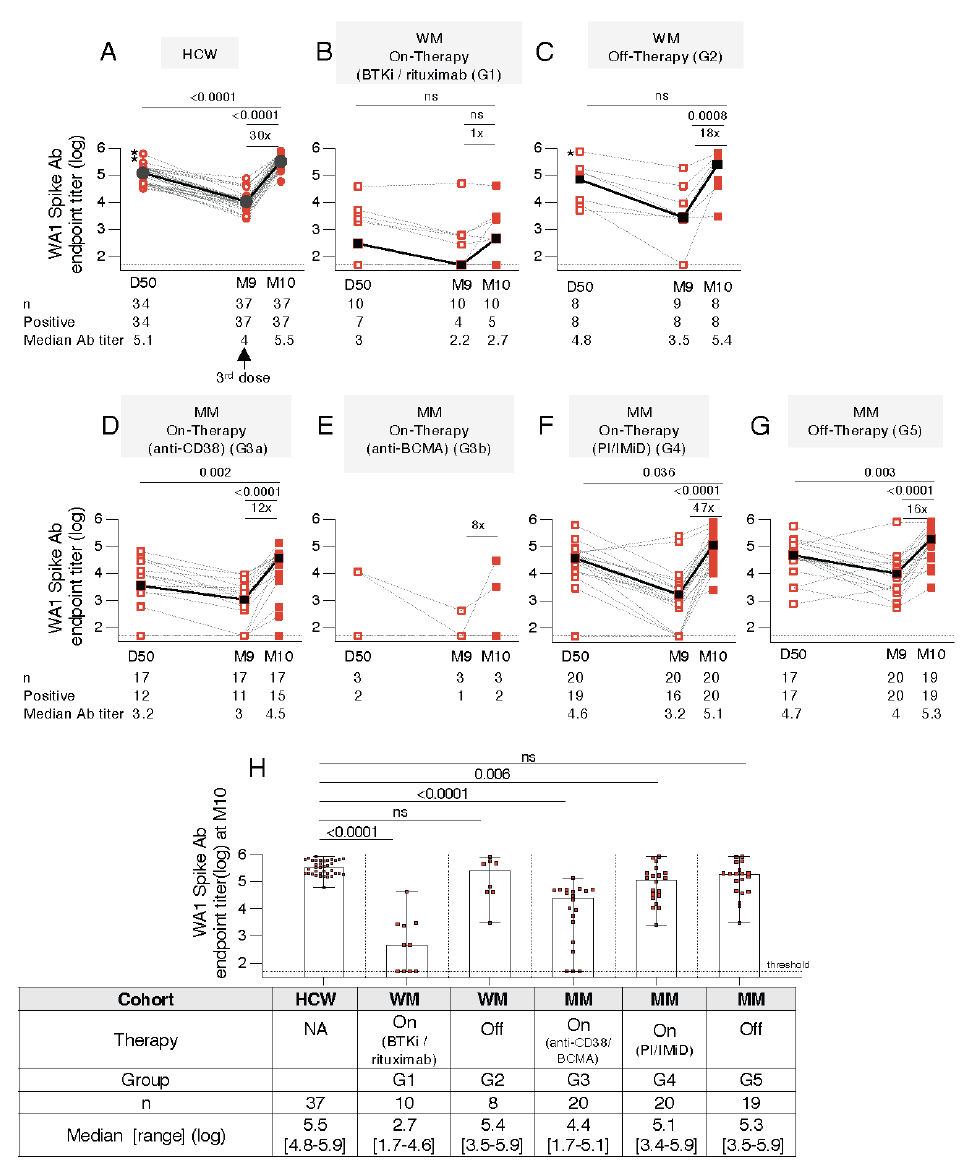
Figure 2. Anti-WA1-Spike antibody levels after the 2nd and 3rd BNT162b2 mRNA. vaccination. Anti-Spike antibody endpoint titers (log) were measured against purified trimeric Wuhan strain (WA1) Spike by an in-house ELISA assay. The measurements were performed overtime at one month after 2nd dose (D50), the day of the 3rd dose (M9) and one month later (M10). ( A – G ) Data are shown for the ( A ) vaccinated HCW; ( B ) WM (G1) and ( D – F ) MM cohorts (G3a, G3b, and G4) enrolled while on active therapy and ( C ) WM (G2) and ( G ) MM (G5) cohorts off-therapy, as de- scribed in Table 1. The number of analyzed samples, the positive responders and median Ab titers are given. For G1, 10 samples were available; for G2, D50 or M10, respectively, were not available for two patients. A titer at or below the threshold of the assay is entered as 50. Asterisks denote one WM patient off-therapy (panel C) and two HCW individuals (panel A) with SARS-CoV-2 infection before study entry. Median values are given in black symbols and black lines. The p values are from t test (Wilcoxon). ( H ) Comparison of Spike antibody endpoint titers at M10. The data for G3a and G3b were combined and reported as G3. The p values are from ANOVA (Friedman test) for the comparisons to the HCW Ab responses. Median antibody titers and range are given. ns – no signifi- cant difference.